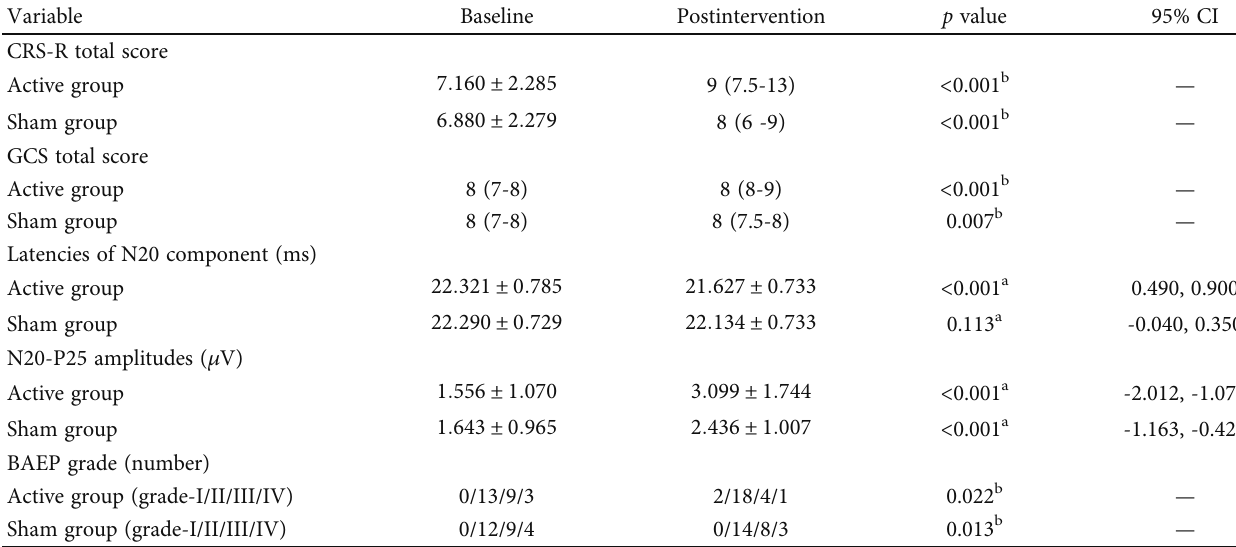
Table 2: Comparison measured parameters at baseline and postintervention in the active and sham